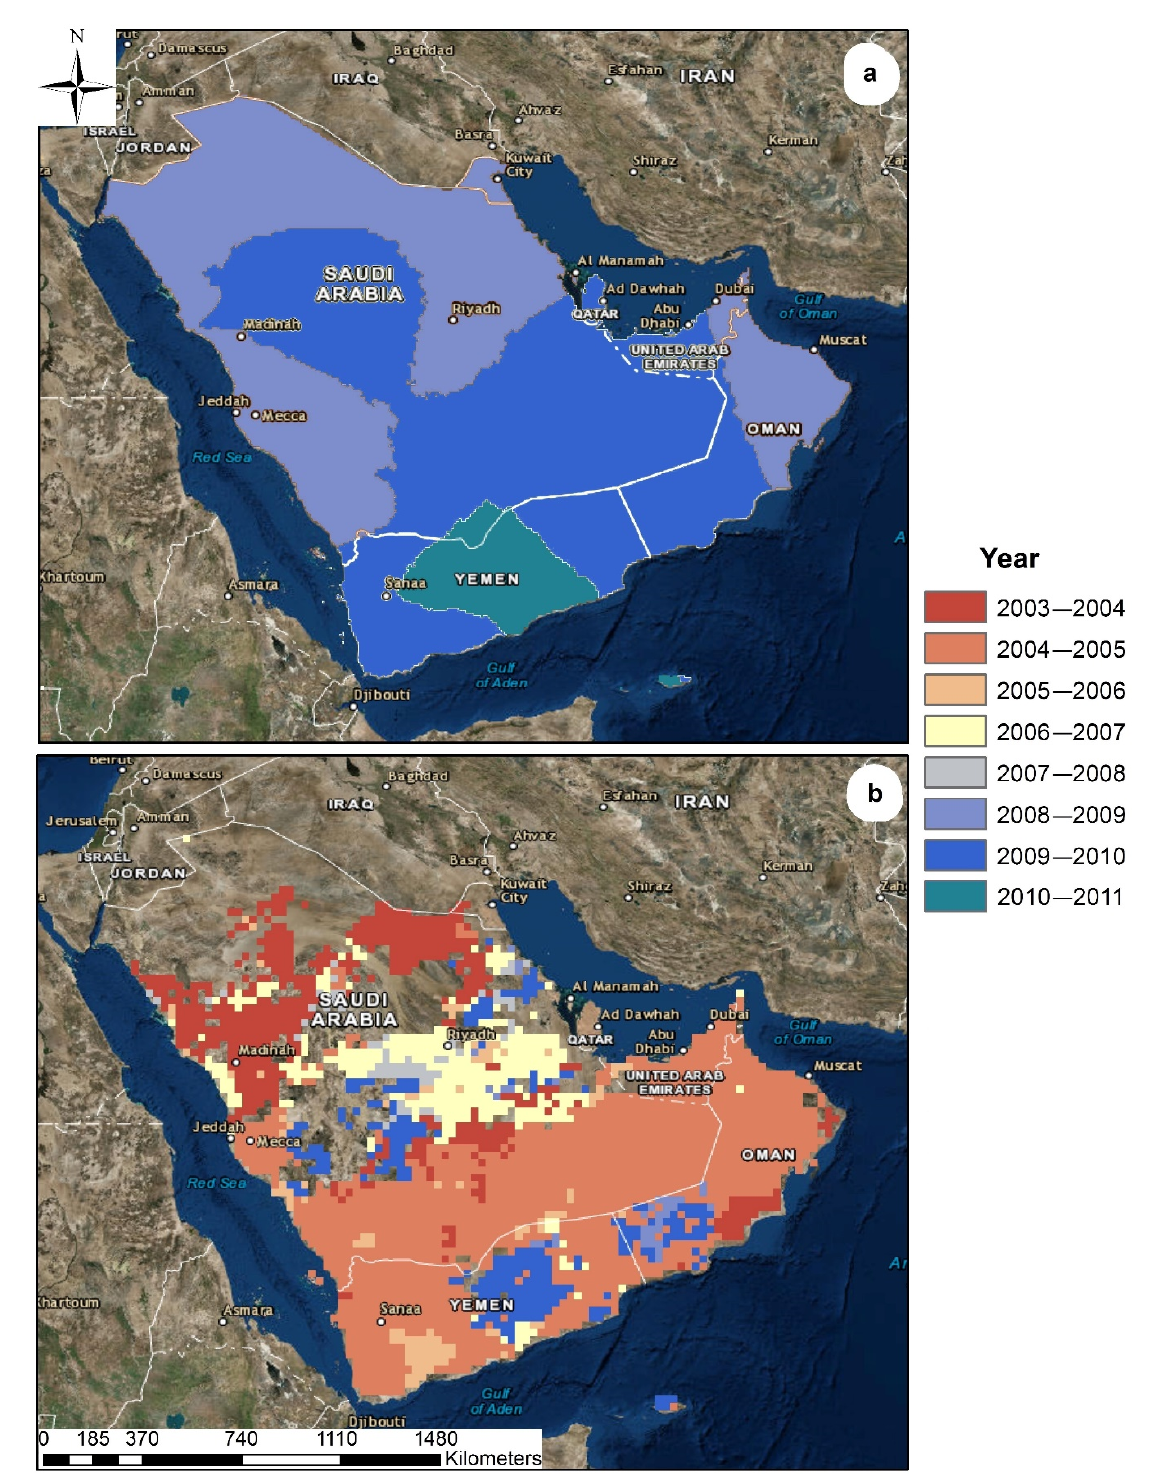
Figure 5. Spatial distribution of detectable change points within the GRACE ( a ) and TRMM ( b ) time series.